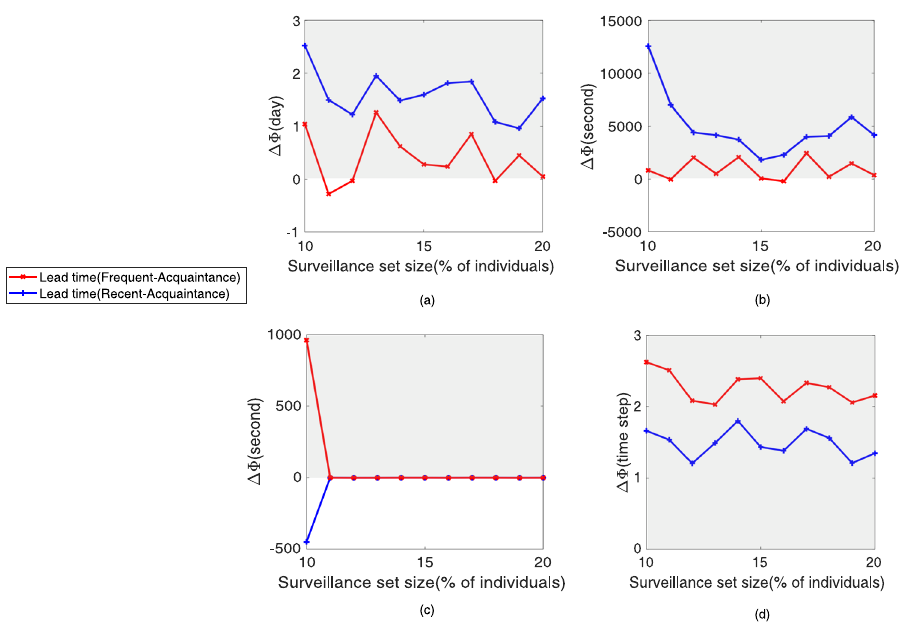
Figure 5. The performance of the Recent and Frequent strategies relative to the Acquaintance strategy. The performance measure ΔΦ is the relative average lead time. The shadow regions indicate an improvement on Acquaintance (the more positive values, the better). The four panels correspond to the four datasets ( a ) Prostitution network, ( b ) Dating network, ( c ) Email network, ( d ) Synthetic